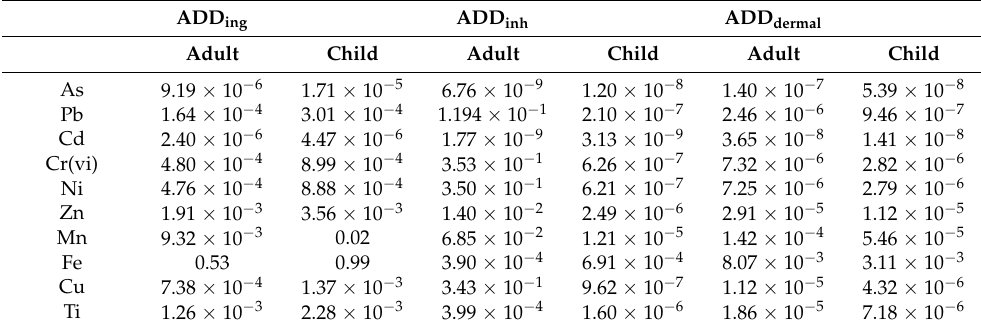
Table 7. Exposure assessment to soil pollution via ingestion, inhalation, or dermal contact. ADD ing ADD inh ADD dermal